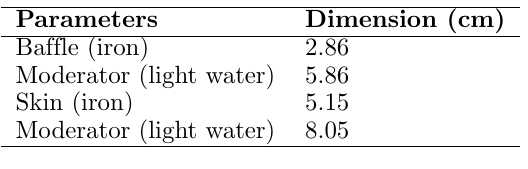
Table 3. Reflector geometrical data [16].